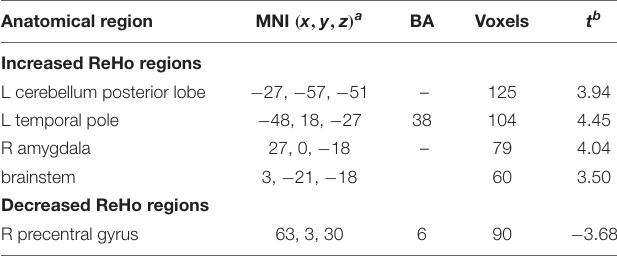
ReHo, regional homogeneity; MNI, Montreal Neurologic Institute; BA, Brodmann’s area; L, left; R, right. a Coordinates of primary peak locations in MNI space; b Represents the statistical value of the peak voxel showing ReHo differences between groups. In the PCCP group, a positive t-value represents increased ReHo, and a negative t-value represents decreased